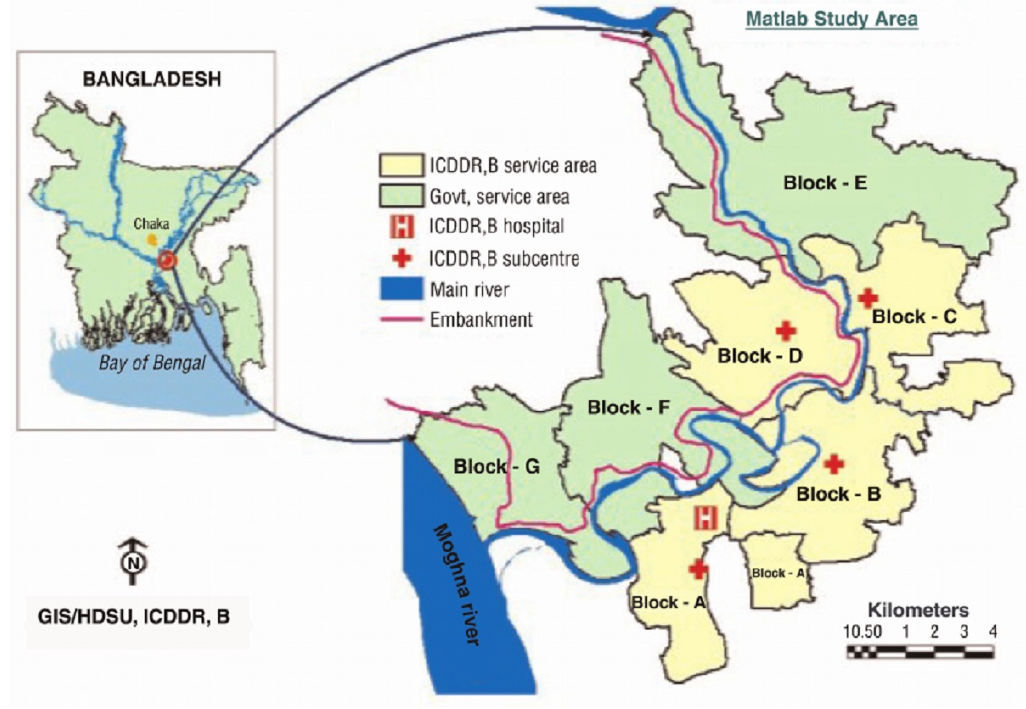
Figure 1. Map of the study area.